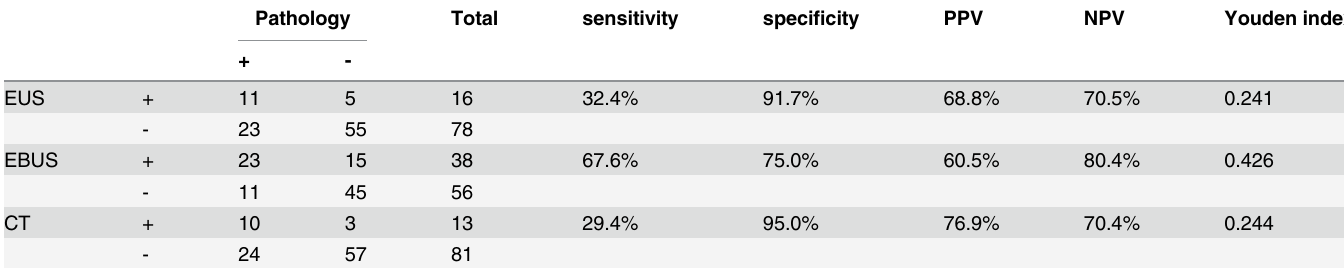
Table 3. Comparison of the accuracy of RLN lymph node metastases by EUS, EBUS and CT with surgical pathology.